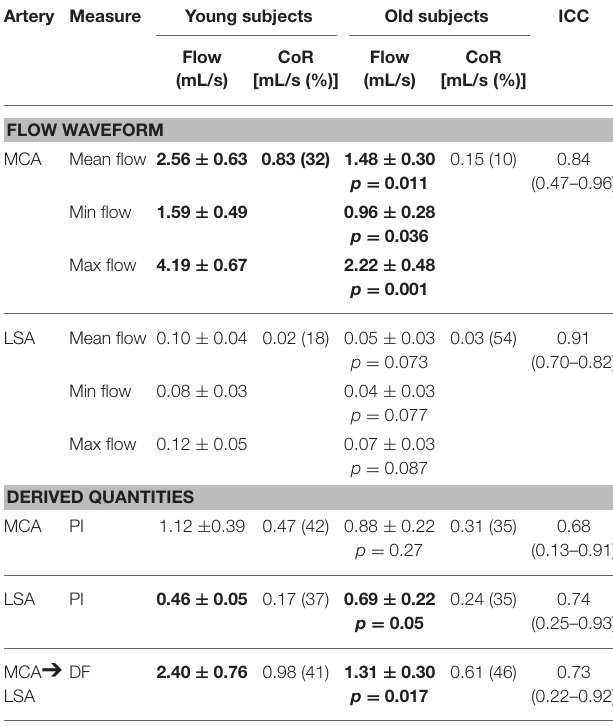
TABLE 1 | Arterial diameters (mm) over the waveform and reproducibility of their mean values. Artery Measure